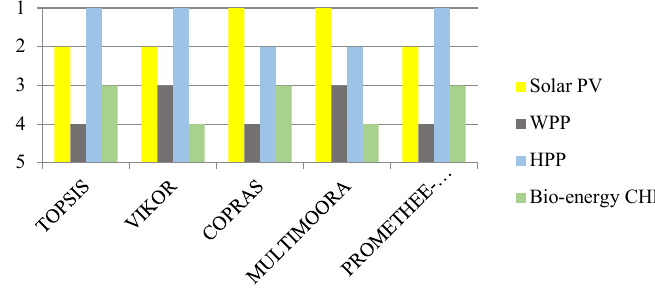
Fig. 4. Result rank of MCDA